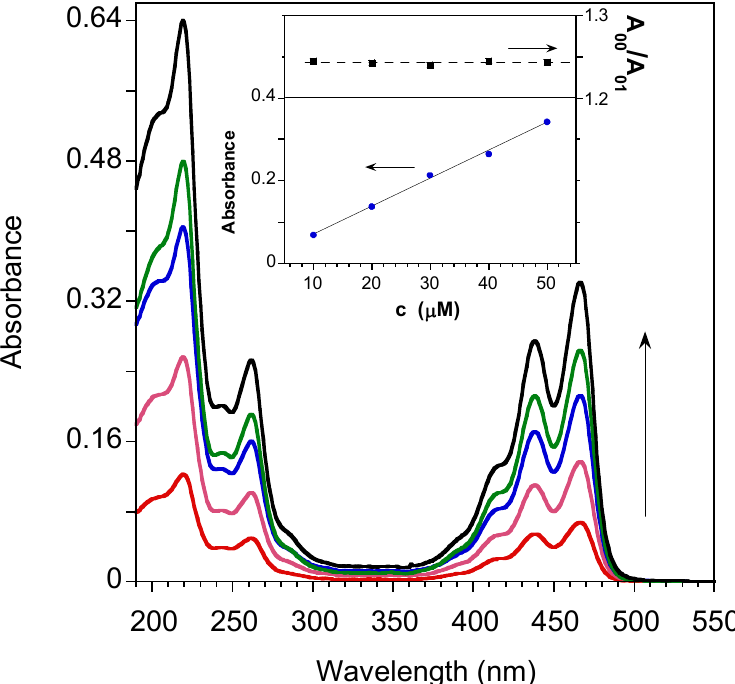
Figure 1. Concentration-dependent absorption spectra of PTAS in water (for 10, 20, 30, 40, 50 µ M concentrations, increasing with the arrow). In the inset, the 0-0 S 0 –S 1 absorbance (lower panel) and the absorbance ratio of the 0-0 and 0-1 peaks (upper panel) are reported as functions of the concentration for a 2 mm optical path